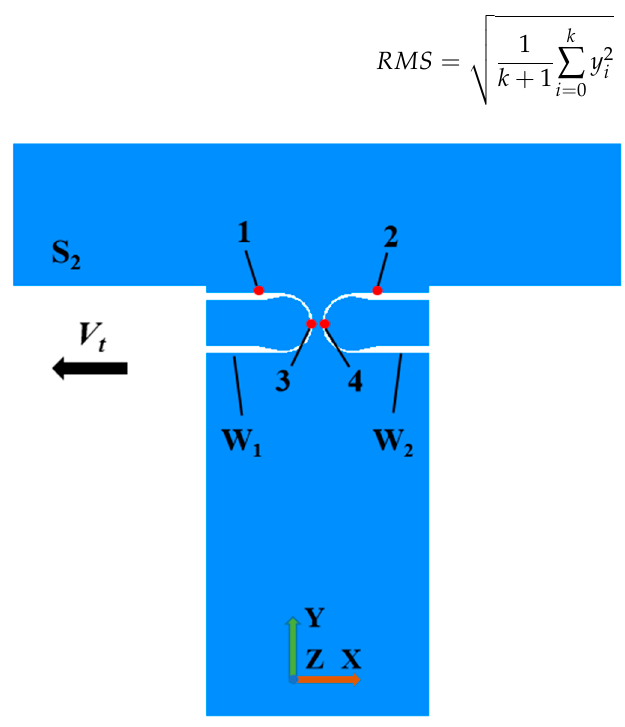
Figure 11. Monitoring points.